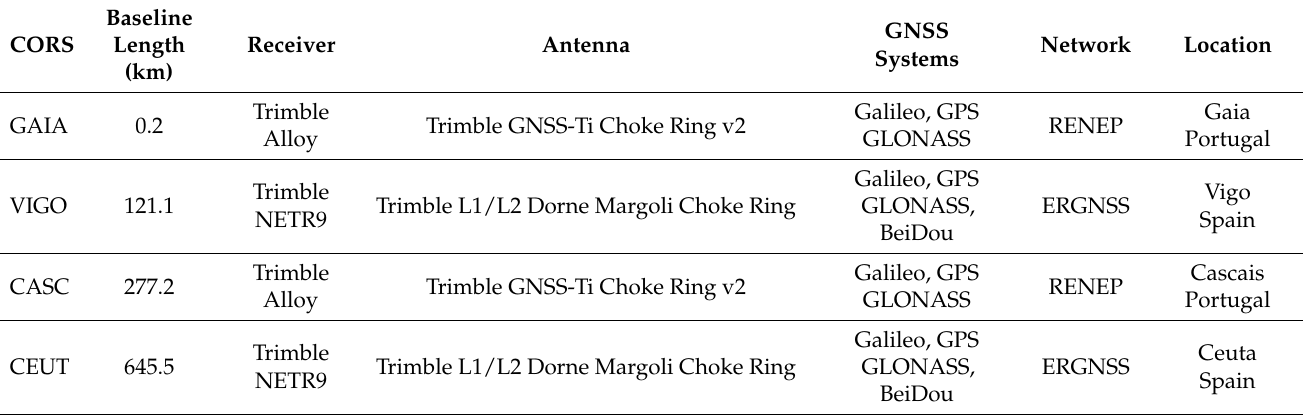
Table 1. CORS from the EUREF used in the